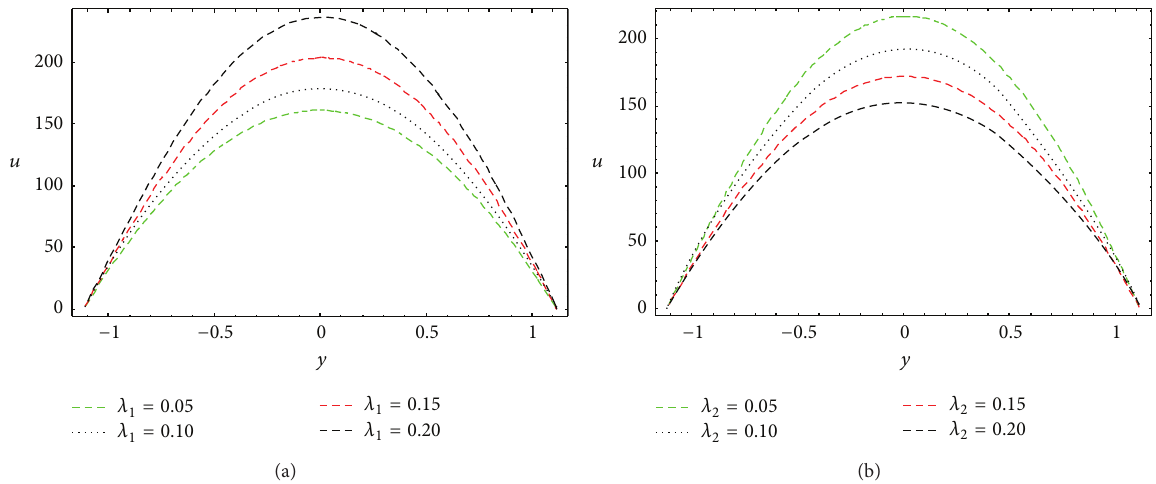
Figure 4: Variation on 𝑢 when 𝐸 1 = 1 , 𝐸 2 = 0.2 , 𝐸 3 = 0.5 , 𝜀 = 0.2 , 𝛽 = 0.05 , 𝑡 = 0.2 , 𝑀 = 1 , 𝛿 = 0.01 , 𝑅 = 0.01 , and 𝑥 = 0.3 plotted for (a) for different values of 𝜆 1 and (b) for different values of 𝜆 2 .